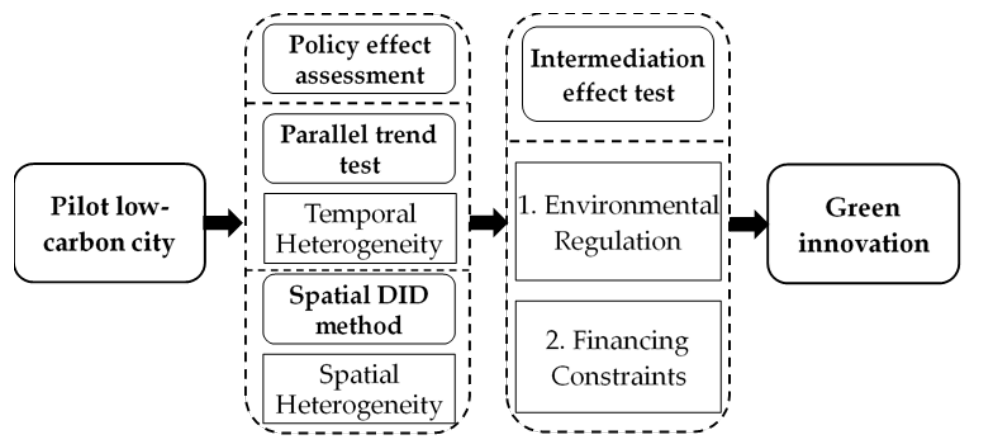
Figure 1. The PLCC policy effect on green innovation.